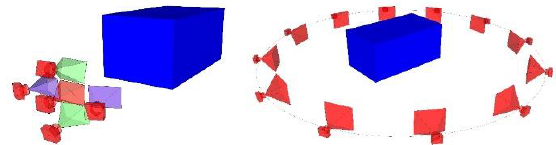
Figure 3. Different acquisition protocols suggested in GRAPHOS. Parallel protocol (left) and convergent protocol